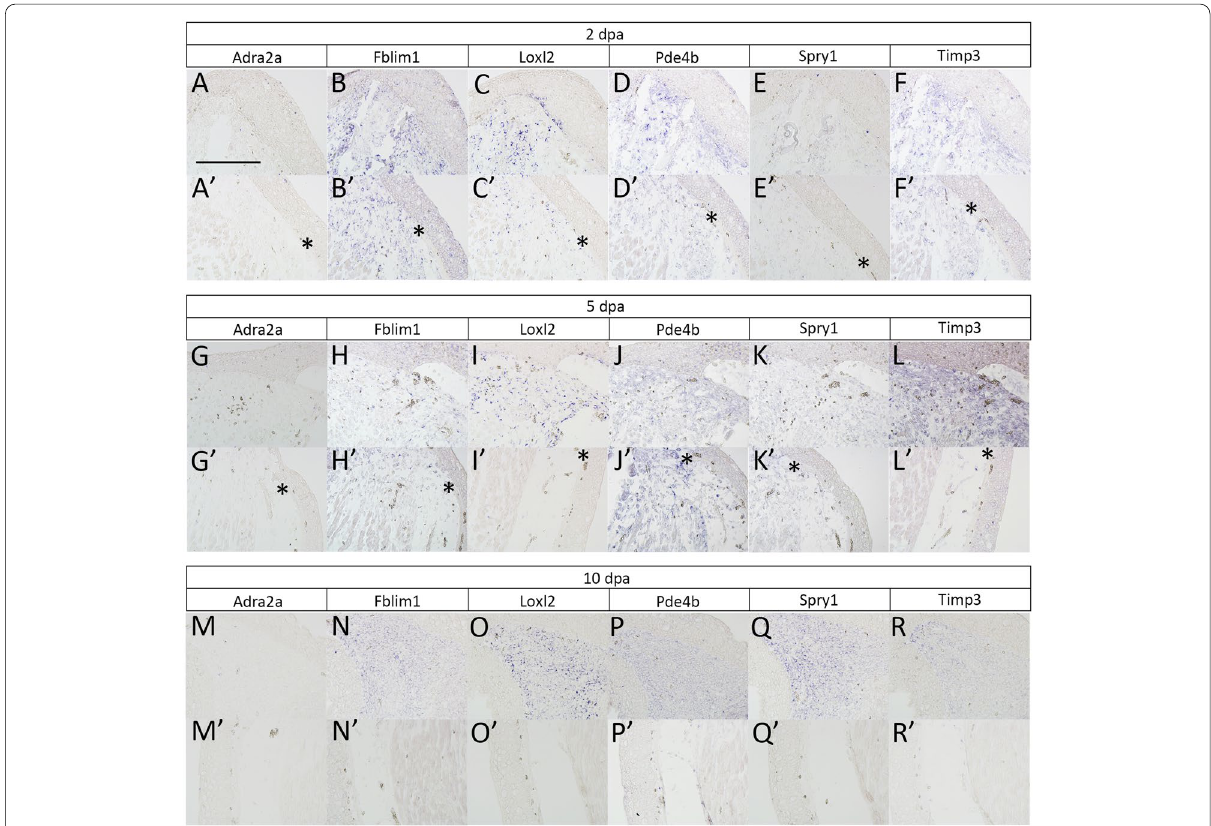
Fig. 5 Gene expression patterns revealed by in situ hybridization. The blastema samples were prepared at 2 dpa ( A – F ), 5 dpa ( G – L ), and 10 dpa ( M – R ). A , G , M expression pattern of Adra2a . B , H , N expression pattern of Fblim1 . C , I , O expression pattern of Loxl2 . D , J , P expression pattern of Pde4b . E , K , Q expression pattern of Spry1 . F , L , R expression pattern of Timp3 . The upper panels ( A – R ) show the distal region of the amputated limbs. The lower panels ( A’ – R’ ) show the proximal or the approximate border of the amputation plane. The asterisks indicate the disconnection of the dermal collagen layer, suggesting the amputation plane. Scale bar in A 400 =